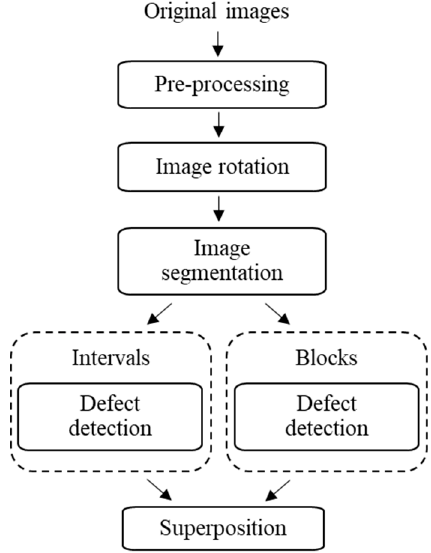
Figure 3. Flow of the overall defect detection algorithm for striped images.